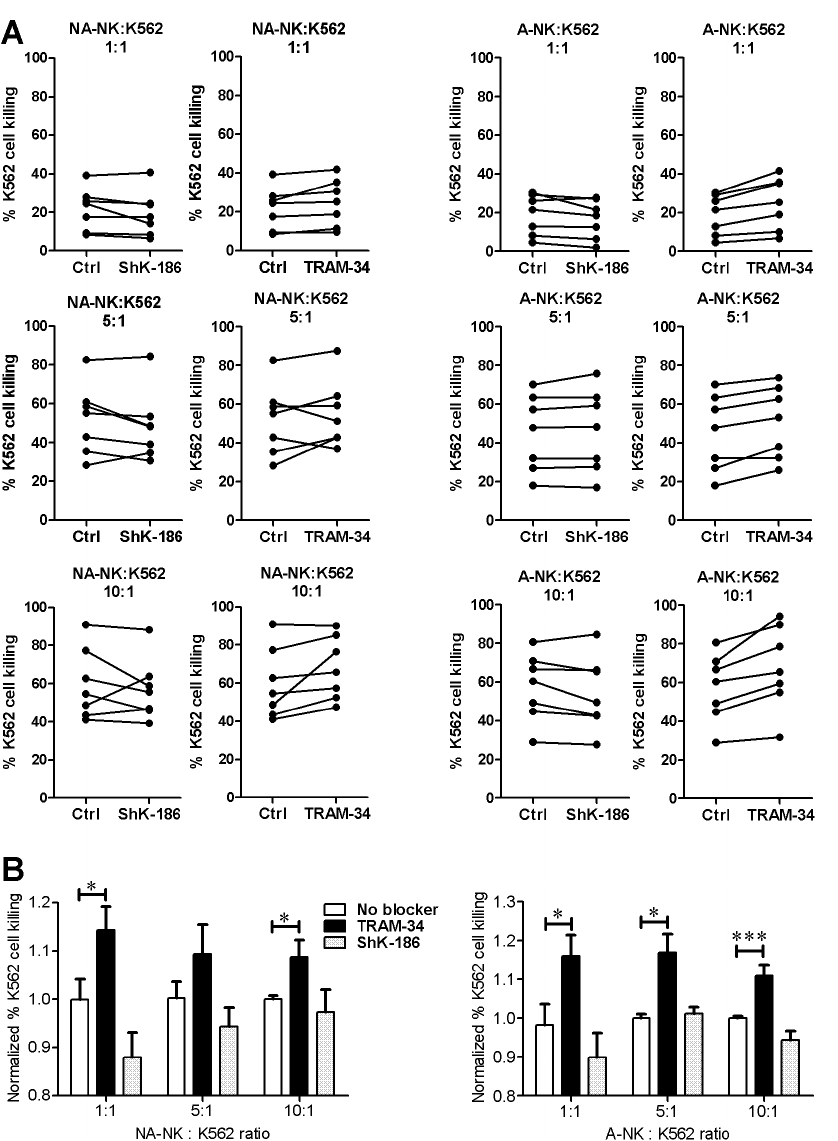
Figure 5. Blocking KCa3.1 and Kv1.3 differentially affects the cytotoxicity of A-NK and NA-NK cells. A: Percentage of dead target K562 cells after incubation with NA-NK or A-NK cells at different NK:K562 ratio in the absence of blocker (left of each plot) or in the presence of 100 nM ShK-186 or 1 m M TRAM-34 (right of each plot). Each data point represents the mean of duplicate assays on single donors. B: Data shown in A normalized for each of the 7 donors to the mean value obtained in the absence of potassium channel block. White, no blocker; grey, 100 nM ShK-186; black, 1 m M TRAM-34. Data represent the mean 6 SEM of data obtained in duplicate with cells from 7 donors in 7 independent experiments. *p , 0.05, **p , 0.01, ***p ,